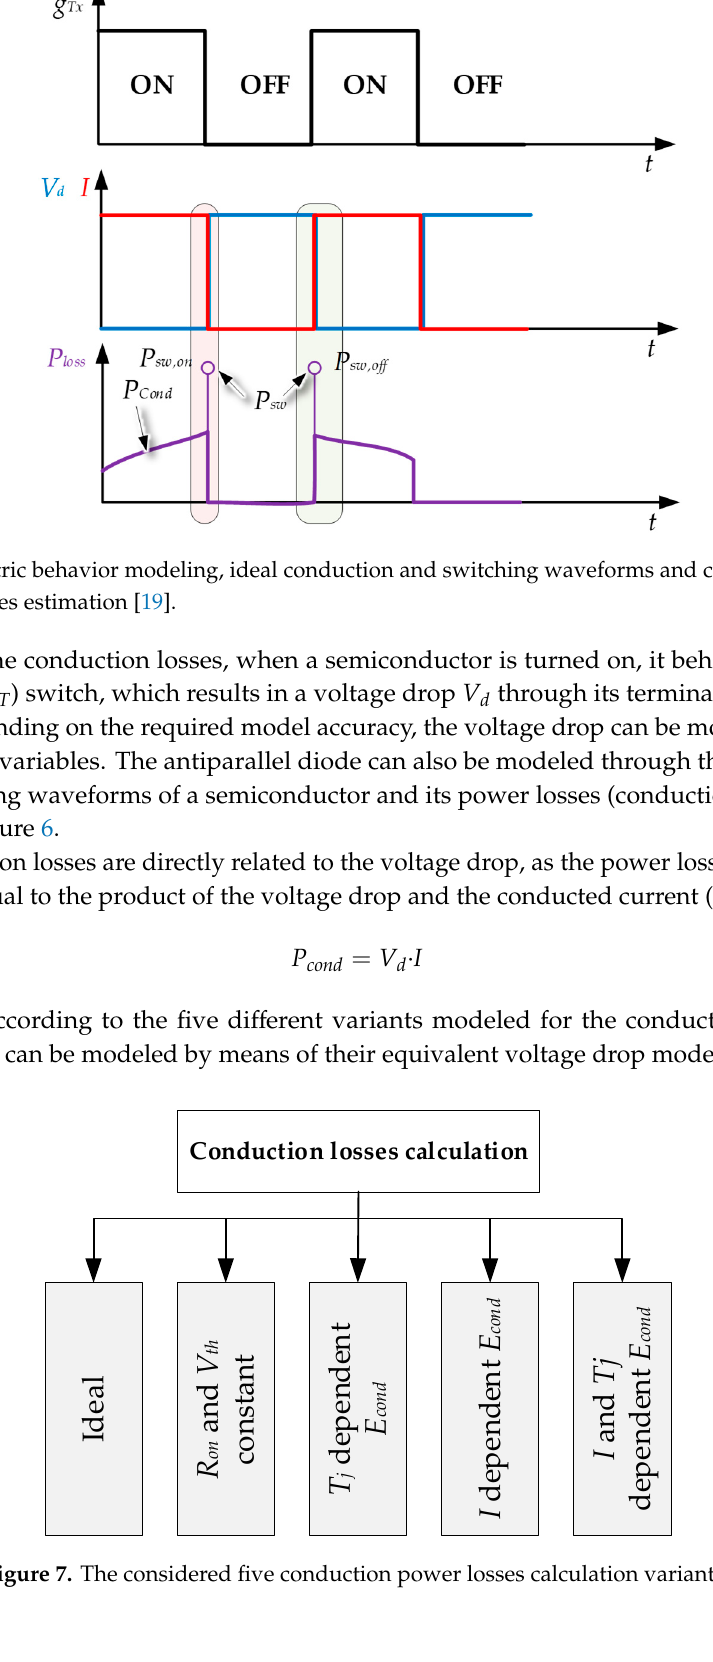
Figure 7. The considered five conduction power losses calculation variants.